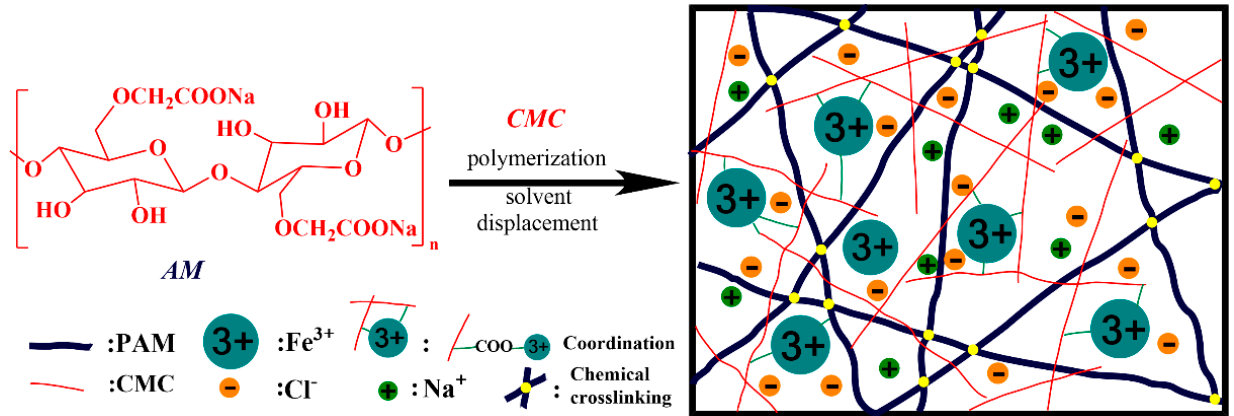
Figure 1. Preparation process and internal structure of PAM/CMC organohydrogel [25]. Copyright 2019 Elsevier Ltd.